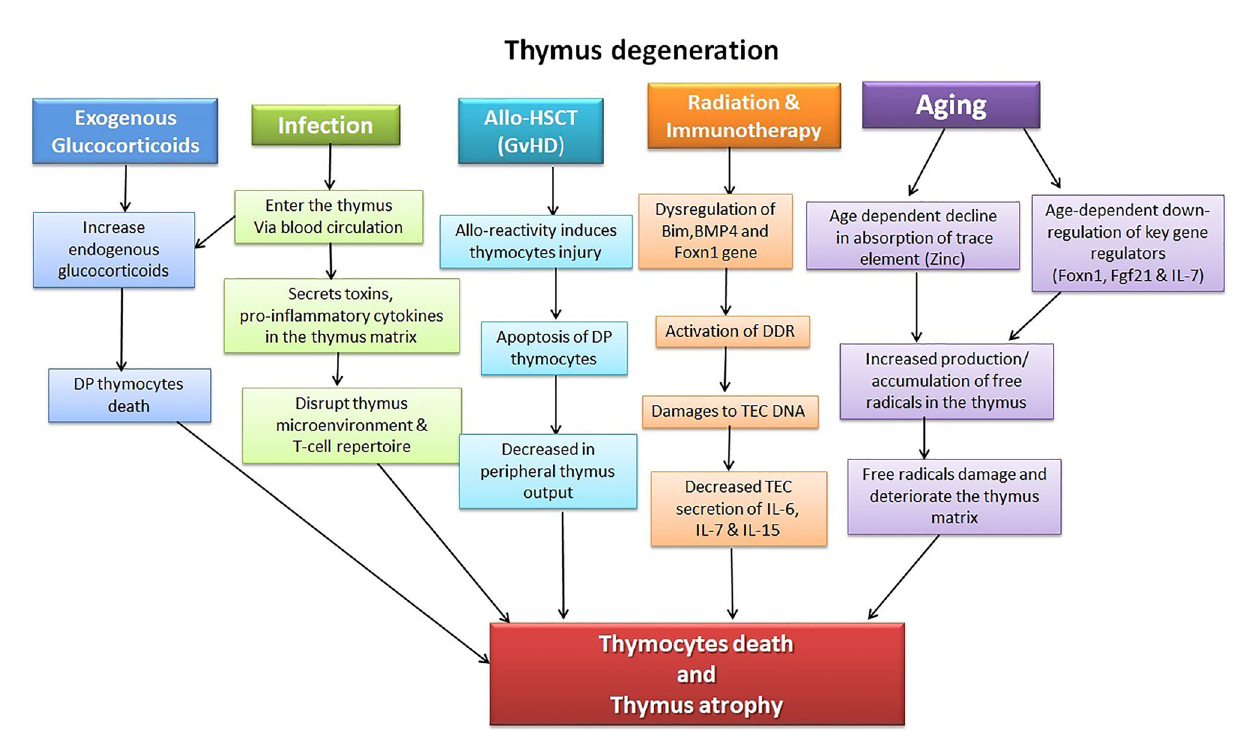
FIGURE 1 | Illustration of factors causing thymic injury. The thymus is a delicate organ sensitive to insults, including chemotherapeutic drugs, corticosteroids, radiation, and pathogens. Allo-HSCT treatment regime and its complications (GVHD) likewise have detrimental effects on the thymocytes. Age-dependent thymic atrophy naturally occurs due to a decline in the thymus ’ s self-renewal capacity and subsequent accumulation of toxic substances, including free